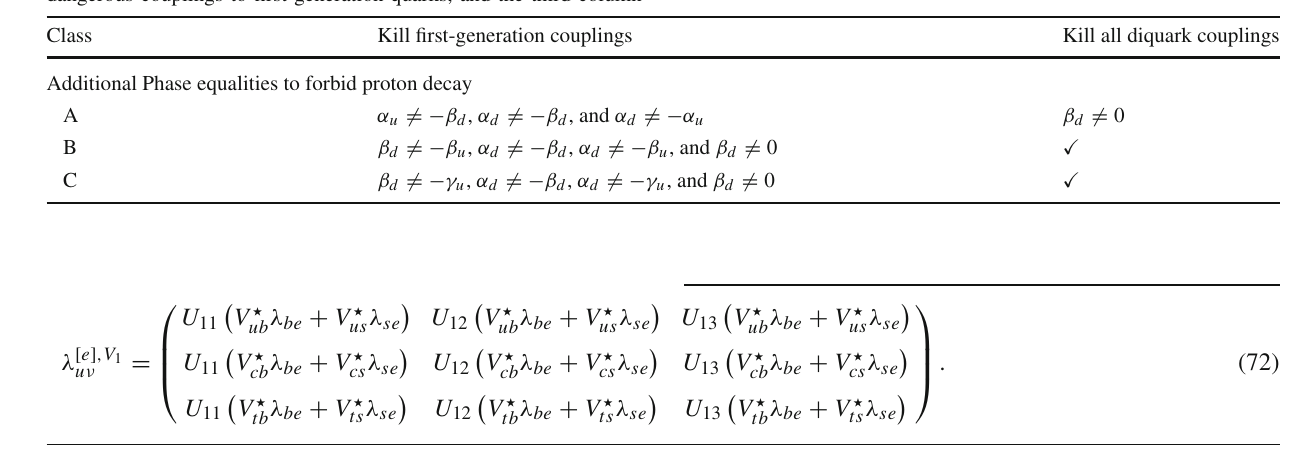
Table 6 Additional phase relationships required to forbid proton decay in the models given in Table 5. Equalities in the second column kill the dangerous couplings to first-generation quarks, and the third column